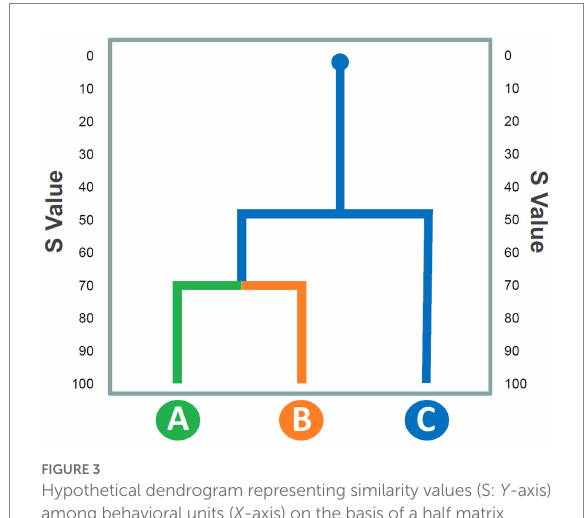
FIGURE 3 Hypothetical dendrogram representing similarity values (S: Y -axis) among behavioral units ( X -axis) on the basis of a half matrix arranged following an aggregative clustering procedure. See text for